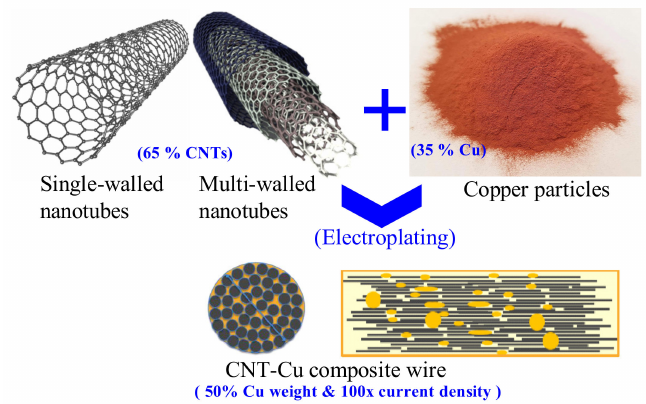
Figure 3. Fabrication of CNT–Cu composite for high current density [15,16].